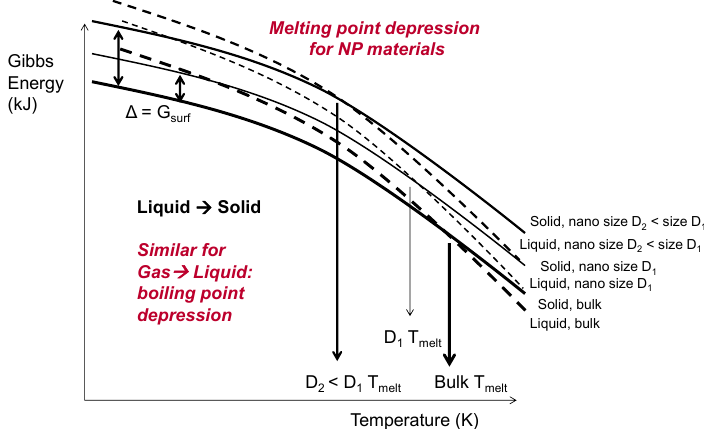
Figure 4. Gibbs energies of nanosized droplets and solid particles vs. those of bulk size materials, showing melting point depression for the diameter D 1 of <<100 nm and D 2 < D 1 .